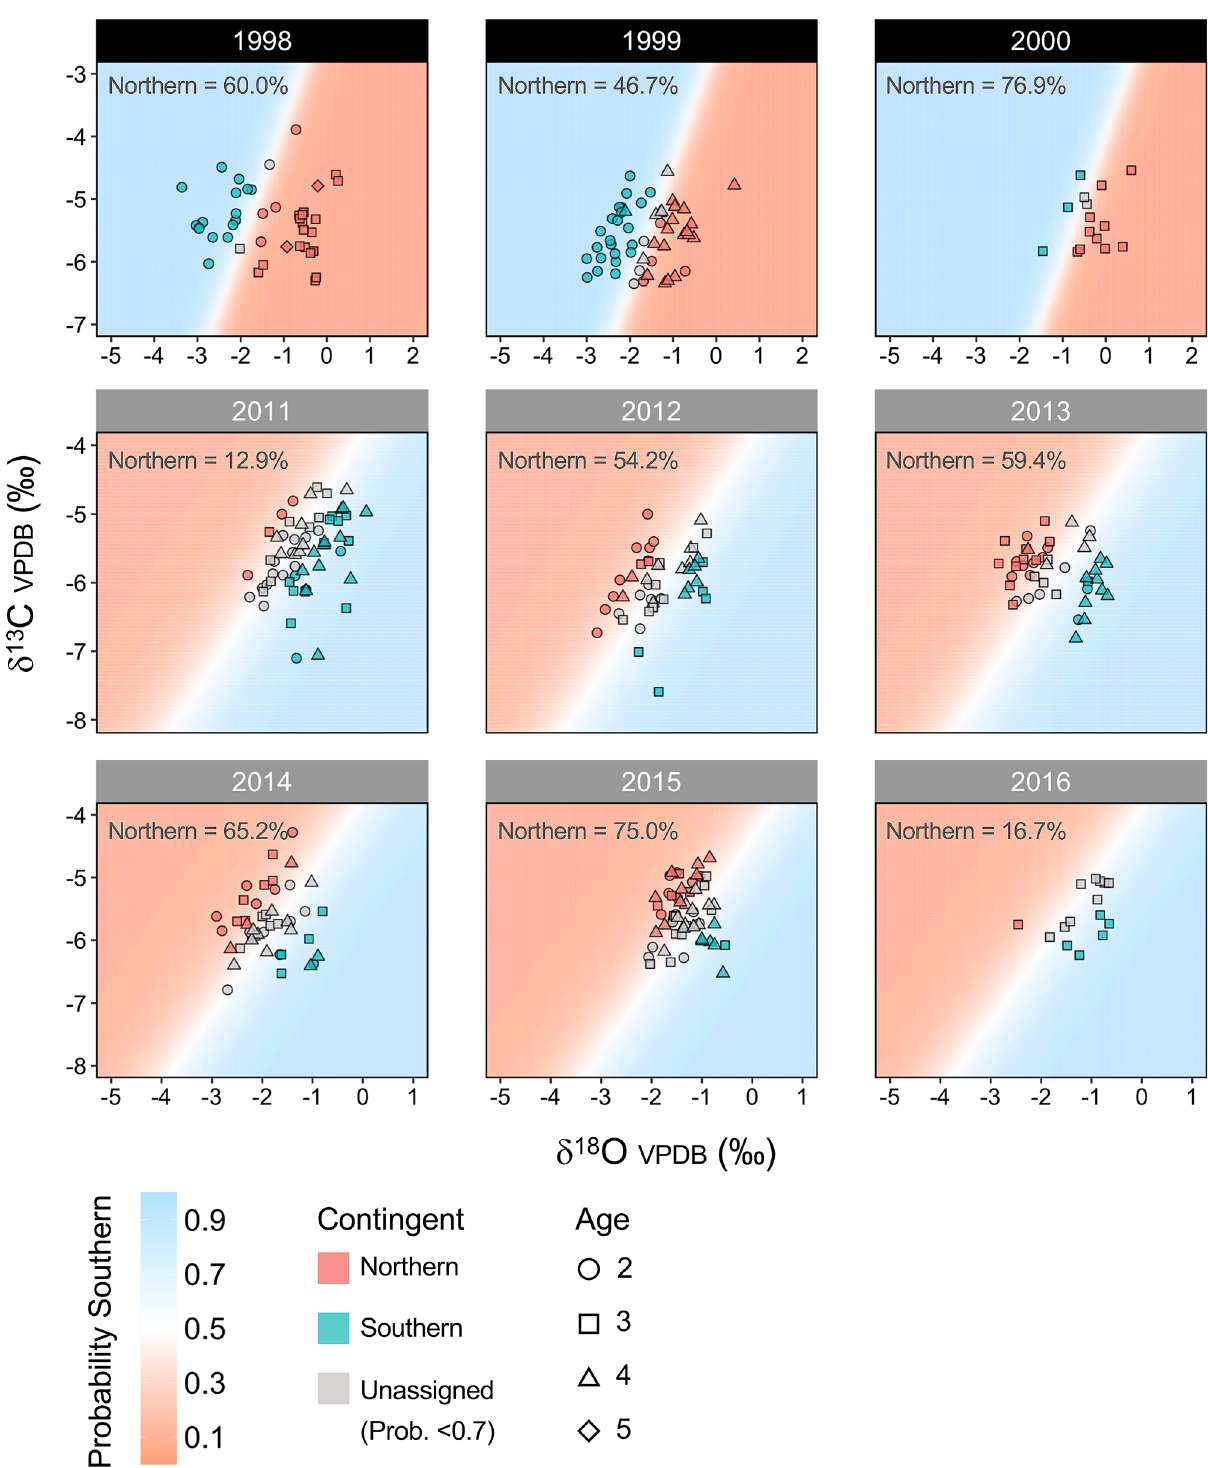
Figure 4. Otolith oxygen and carbon stable isotopes (δ 18 O/δ 13 C values) for age ≥ 2 unknown adult Northwest Atlantic mackerel samples collected in the US shelf waters for 9 year-classes (1998–2000 and 2011–2016) classified based on the binomial generalized linear mixed model. Background colors indicate the probability of each individual assigned to either contingent (0.7 threshold). Different symbols represent different age-classes within each year-class. The proportion of the northern contingent of assigned fish (probability > 0.7) for each year-class is shown in the top left corner of each panel. All isotope values were reported in delta notation with respect to Vienna-Pee Dee Belemnite (V-PDB). Note that classification baselines were developed separately for the older and recent year-classes and the scales of the x- and y-axes differ between those